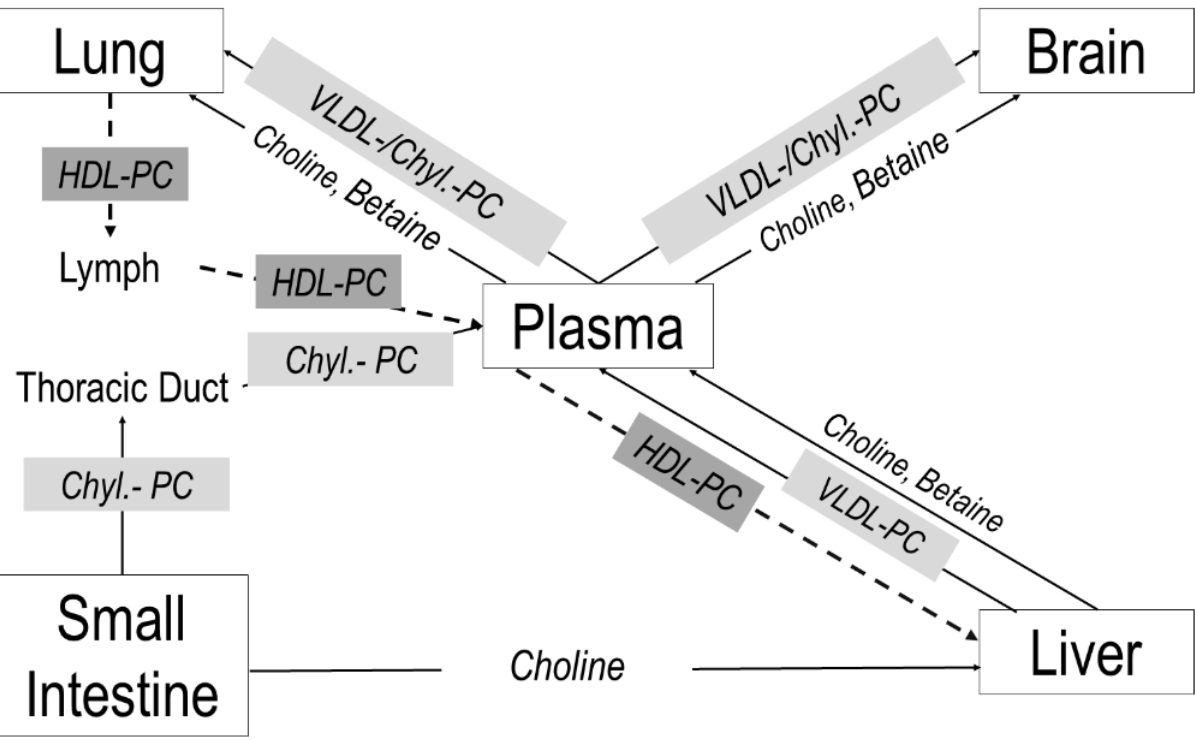
Figure 7. Choline trafficking in neonatal target organs. Arrows indicate the flux directions of choline and its metabolites between the lung, brain, intestine and liver via plasma and lymph fluid. Abbreviations: Chyl, chylomicron; PC, phosphatidylcholine; HDL, high-density lipoproteins, VLDL, very-low-density lipoproteins.